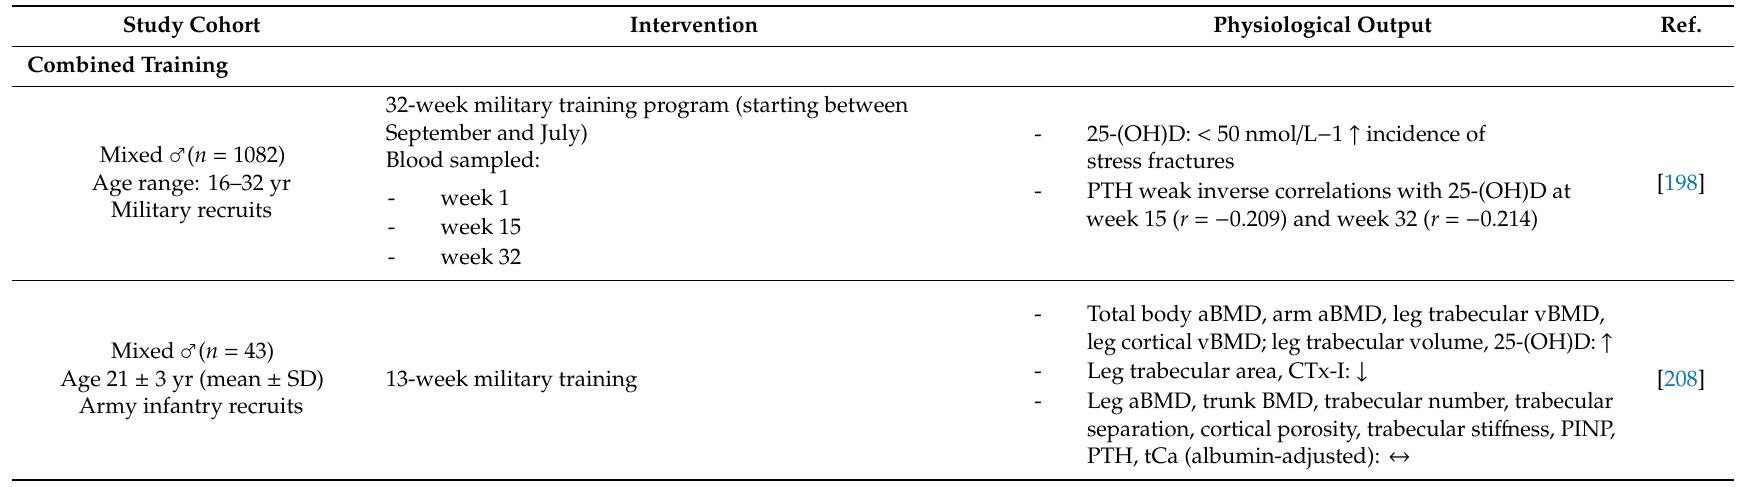
Intervention Physiological Output